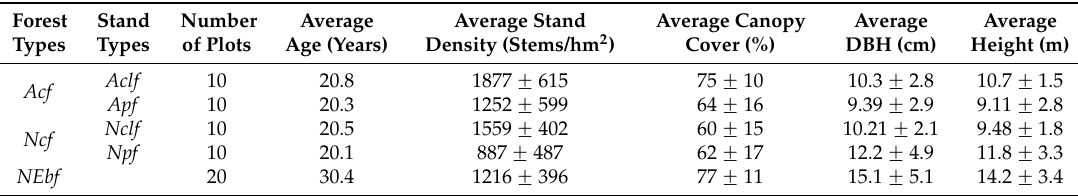
Table 1. General status of the experimental